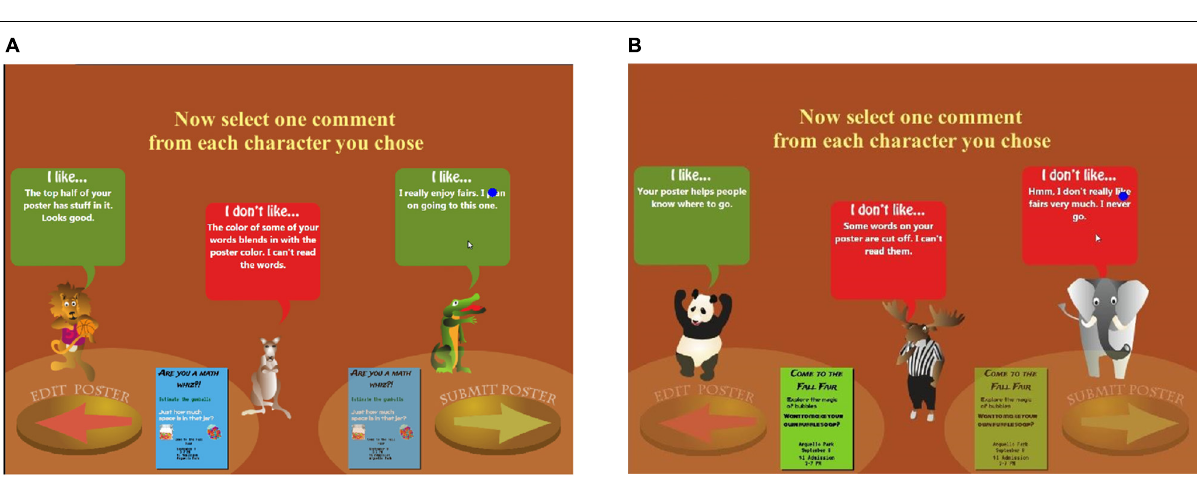
FIGURE 2 | The gaze on the feedback area of a participant in the Assign version of the Posterlet game is represented as a dark-blue dot. The participant reads confirmatory feedback in panel (A) (“I really enjoy fairs. I plan on going to this one.”) and critical feedback in panel (B) (“Hmm, I don’t really like fairs very much. I never